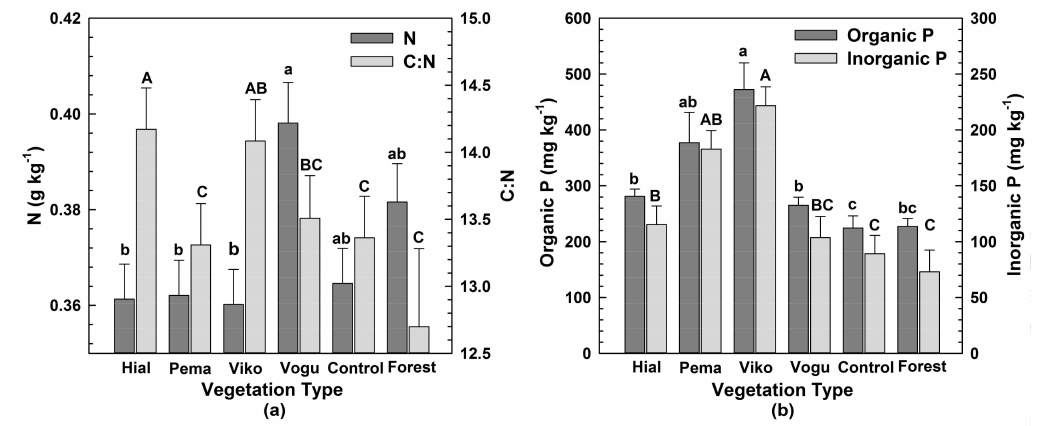
Figure 2. Effect of vegetation type on: ( a ) N concentrations (left y -axis) and C:N (right y -axis) and ( b ) Organic P (left y -axis) and Inorganic P (right y